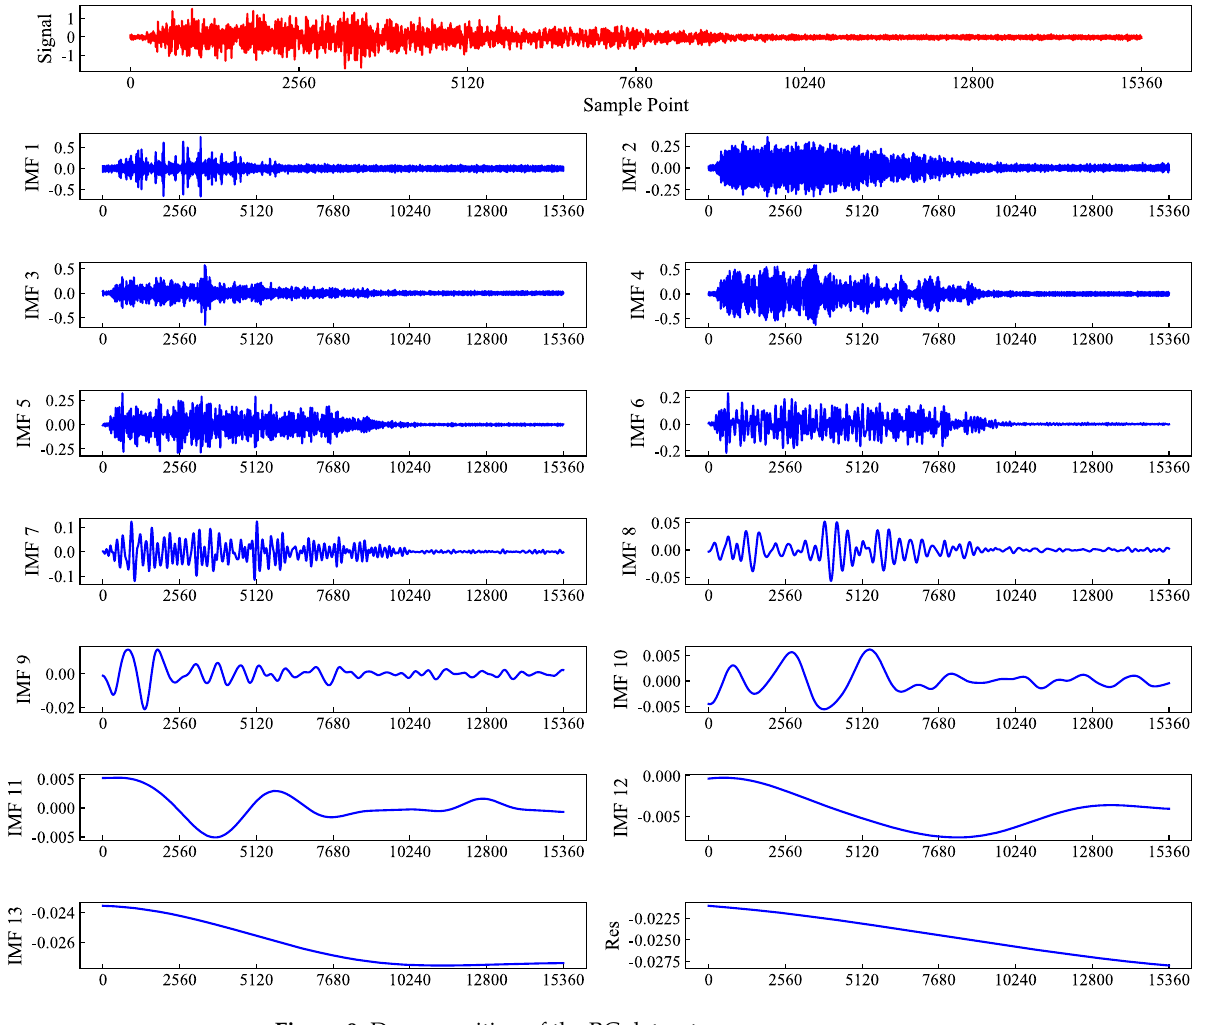
Figure 9. Decomposition of the RG dataset.